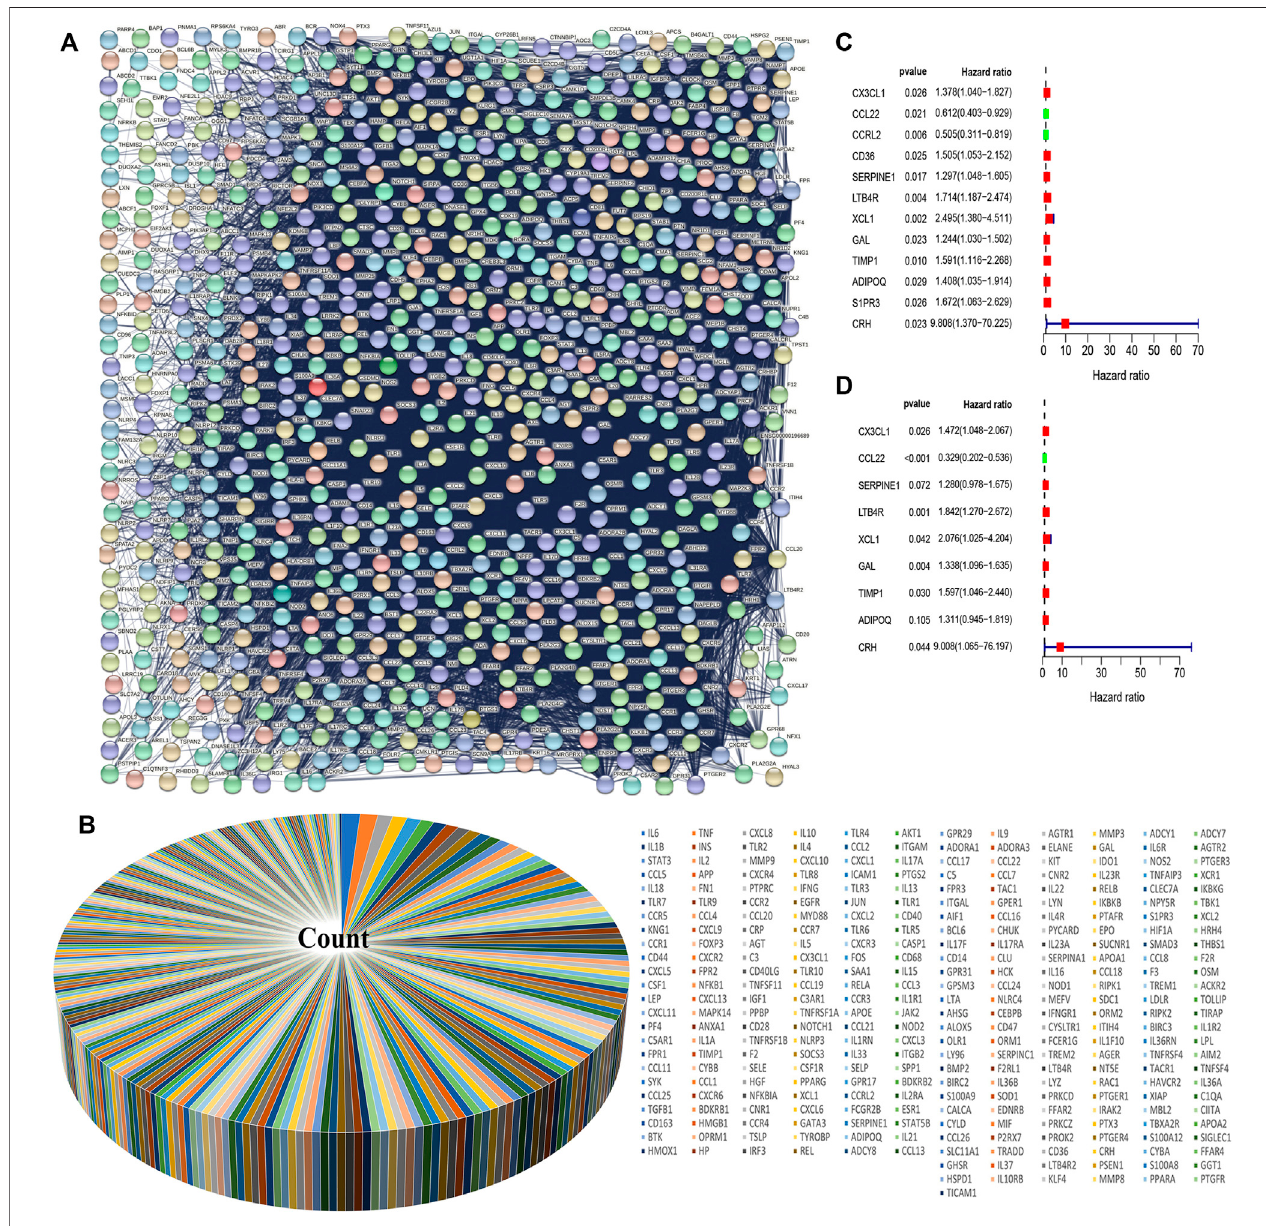
FIGURE 1 | Screening of in fl ammatory response genes and their in fl uence on prognosis. (A) Protein interaction network of in fl ammatory response genes. (B) The 301 in fl ammatoryresponse geneswith the largest number ofadjacent nodes have been representedby apie chart. (C) The genes with p value < 0.03 were screened by univariate Cox regression analysis. (D) Multivariate Cox regression analysis was performed to select the in fl ammatory response genes that can independently affect the prognosis.